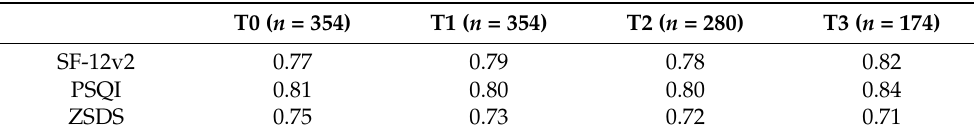
Table A1. Cronbach’s alpha reliability coefficients of the instruments at the different measure- ment